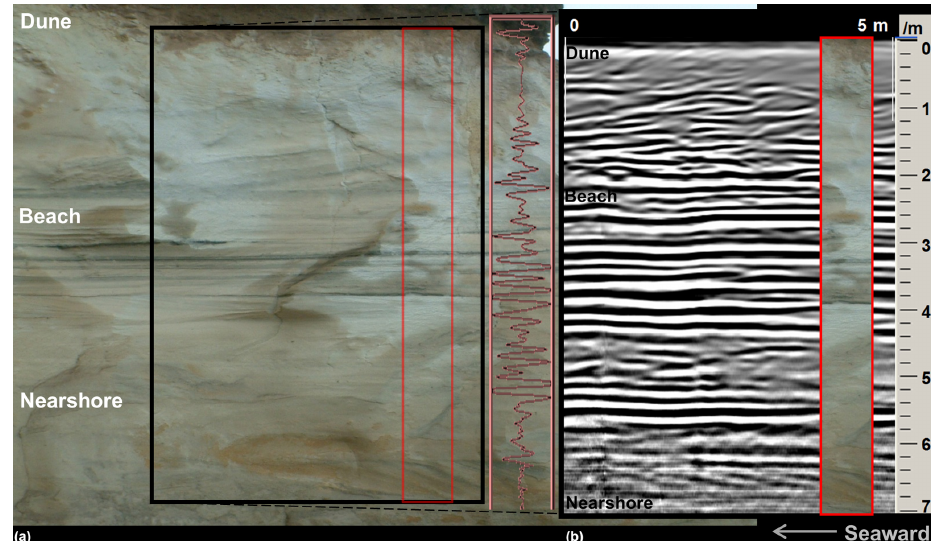
Figure 3. (a) Photograph of a scarp that cross-cuts a prograded Pleistocene barrier located near One Tree Point, New Zealand. This outcrop displays the small-scale stratigraphy of the barrier facies: dune, beach, and nearshore. (b) Transect of GPR data collected along the top of this outcrop that accurately maps the sedimentary beds exposed and records the internal barrier structure in detail. A single waveform is displayed between the GPR data and the corresponding outcrop to exemplify how the wave-amplitude spikes correspond to changes in the stratigraphy and laterally form the strong or weak reflections in the geophysical data. The section of the outcrop photo (outlined in red) is overlain on the GPR data to demonstrate the need to ground-truth the geophysical data with cores to determine the cause of the reflections. Note that all of these overlays are approximate as GPR had to be collected a small distance from the cliff to minimize edge effects within the geophysical data. Figure modified from Dougherty and Nichol